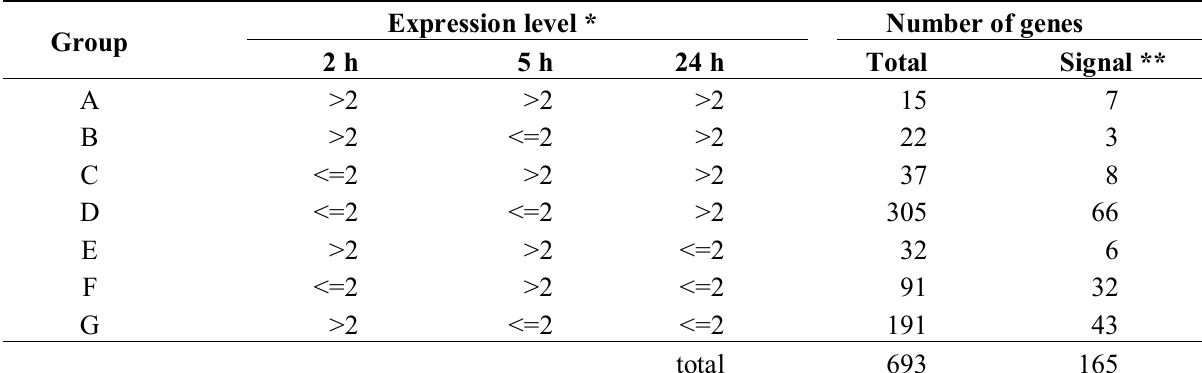
Table 3. Classification of genes whose expression was induced at acidic pH.